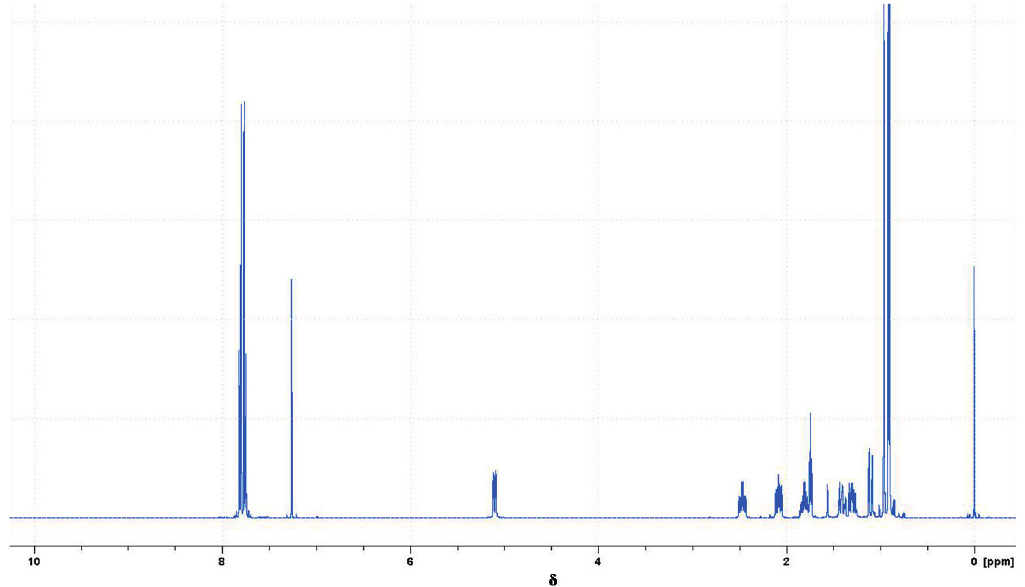
Figure 1. 1 H NMR spectrum of the chiral